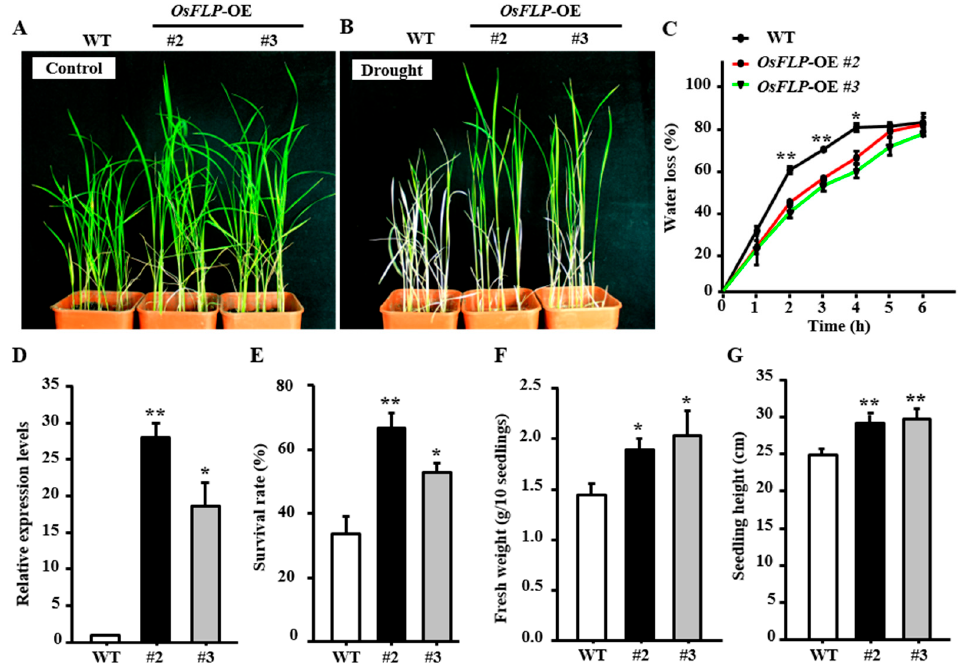
Figure 3. Overexpressing OsFLP enhanced plants' drought tolerance. ( A ) Four-week rice seedlings grown under normal conditions. ( B ) Four-week rice seedlings were not watered for 14 days and re-watered for 5 days. ( C ) Water loss of detached leaves. Error bar means ± SD. ( D ) The expression levels of OsFLP transgenic lines were detected by qRT-PCR. Error bar means ± SD. ( E ) Analysis of survival rate after drought treatment. ( F ) Fresh weight of wild-type and transgenic lines after drought treatment. ( G ) Seedling height of wild-type and transgenic lines after drought treatment. Error bar of ( E − G ) means ± SE ( n > 36 plants). Asterisks indicate a significant difference between OsFLP − OE lines to wild-type. (Student’s t -test, ** p < 0.01, * p < 0.05).